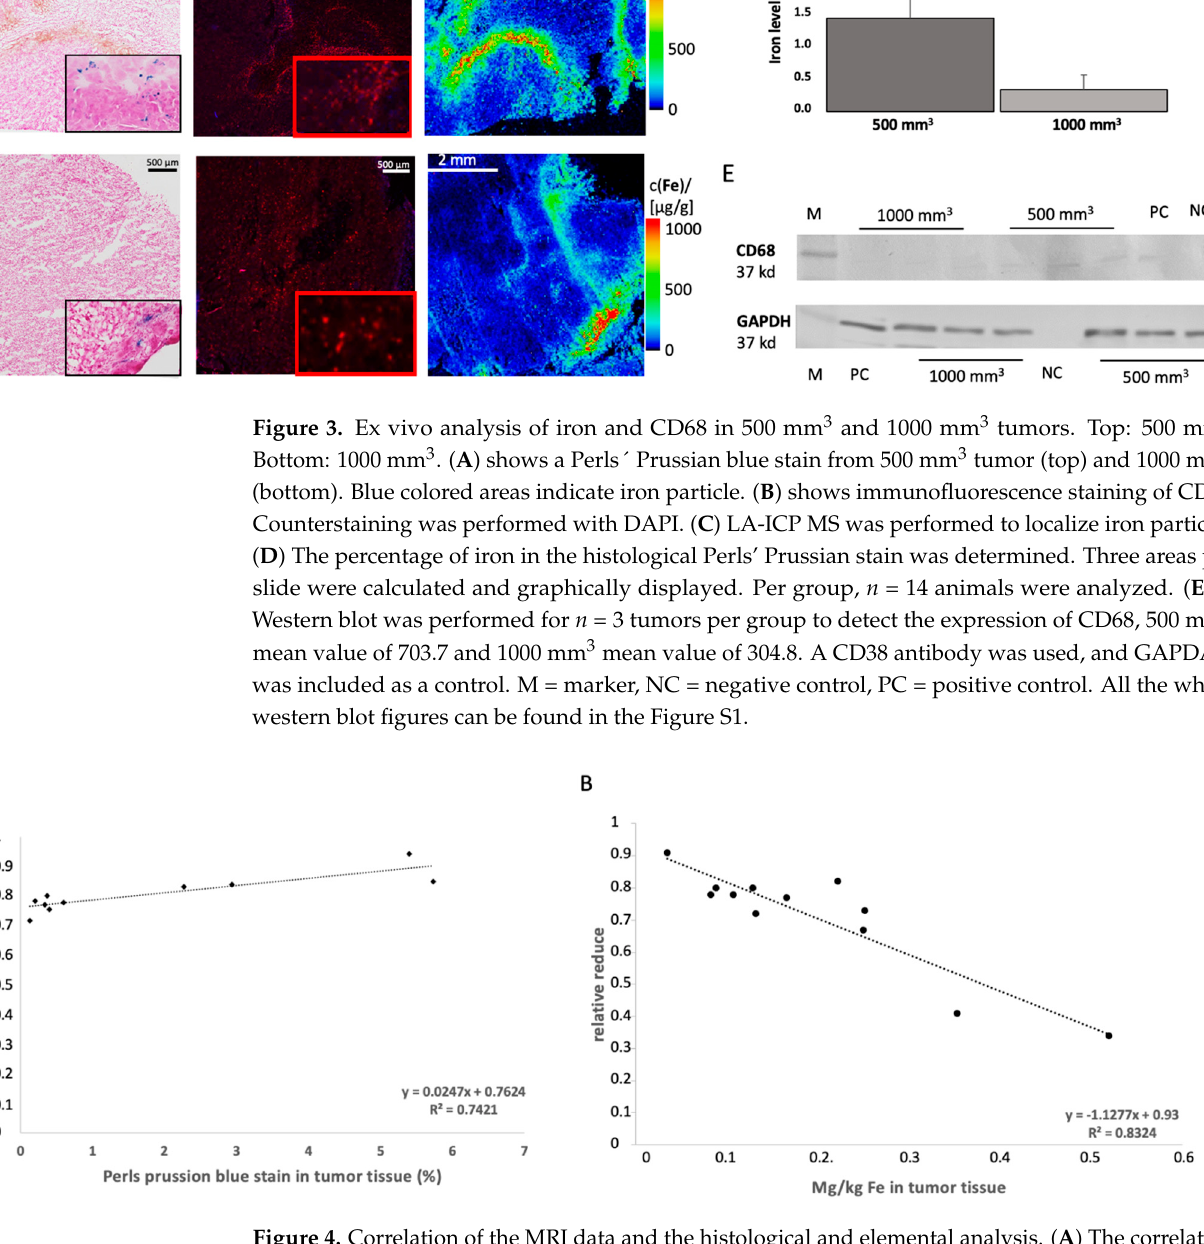
Figure 4. Correlation of the MRI data and the histological and elemental analysis. ( A ) The correlation between the Perls’ Prussian blue staining percentage and the relative enhancements show a correlation (y = 0.025x + 0.76; R 2 = 0.74). ( B ) shows a correlation between the relative enhancement and the ICP-MS analyses for Fe. A correlation is shown (y = − 1.13x + 0.93; R 2 = 0.83).